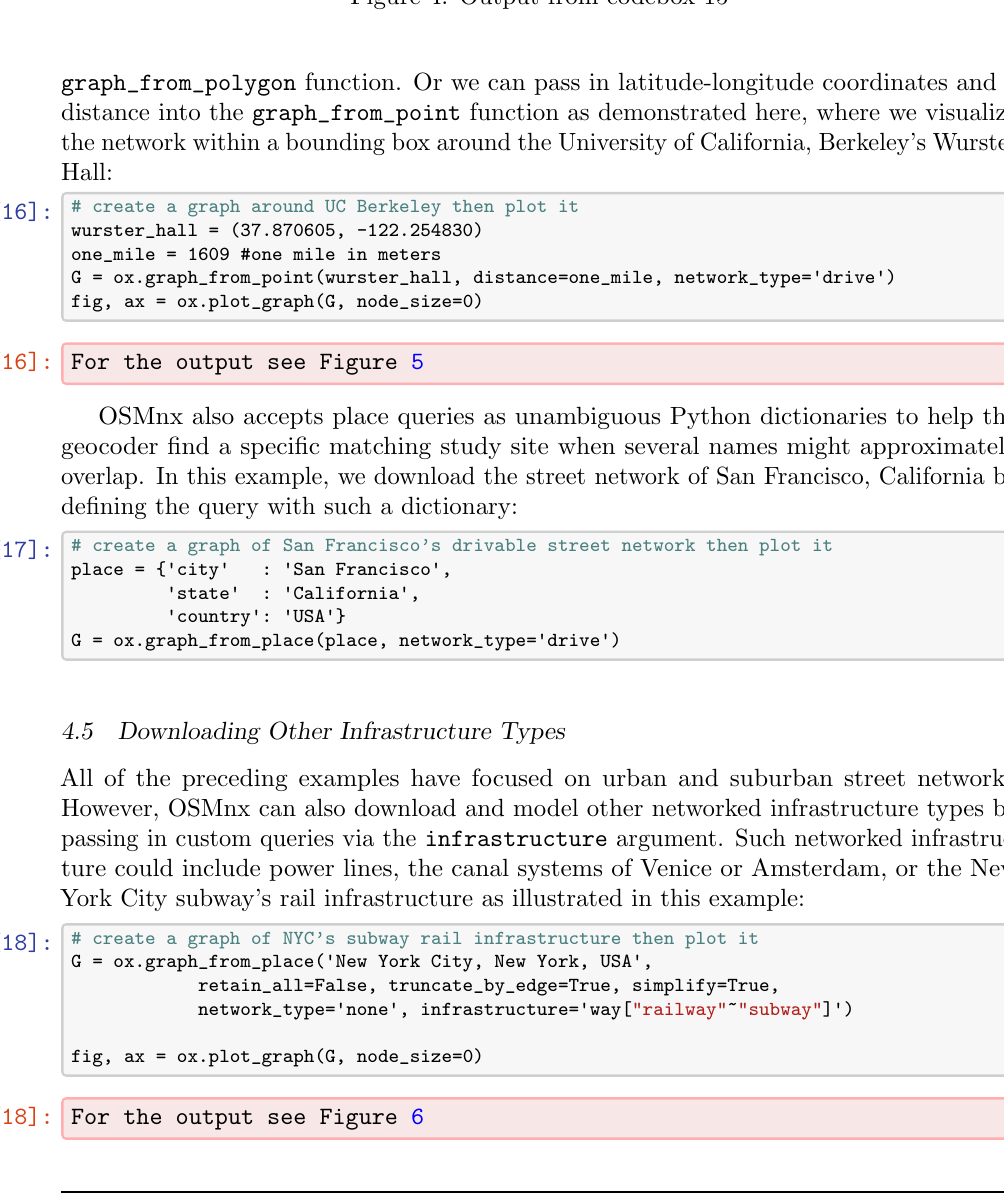
Figure 4: Output from codebox